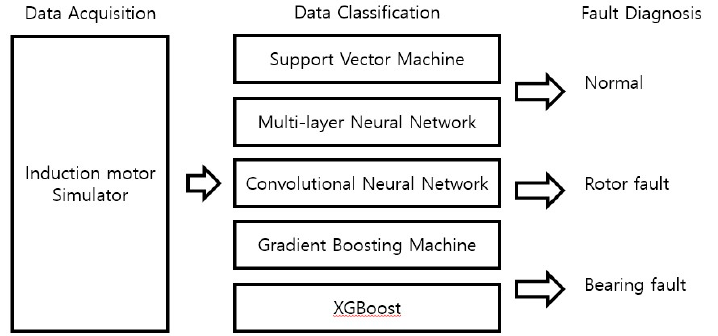
Figure 5. Block diagram of the fault diagnosis algorithm for an induction motor.